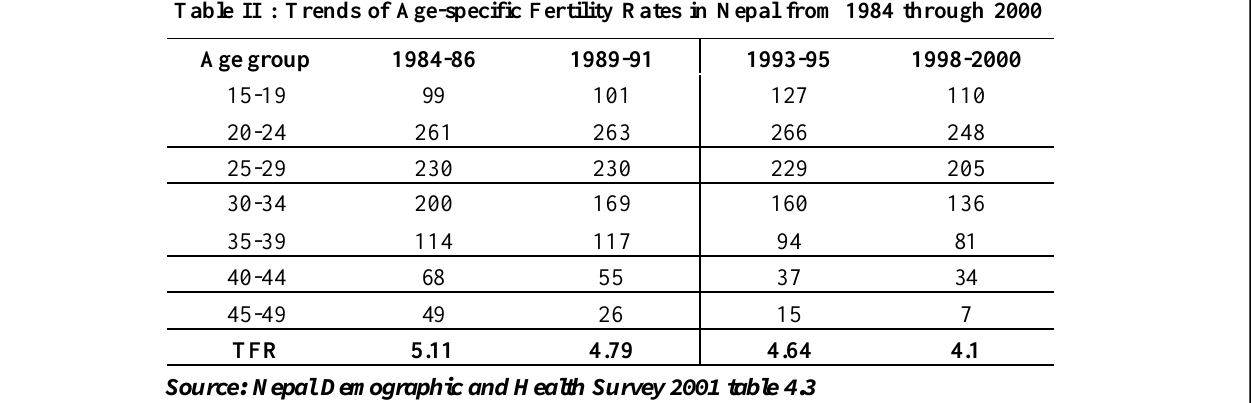
Table II : Trends of Age-specific Fertility Rates in Nepal from 1984 through 2000